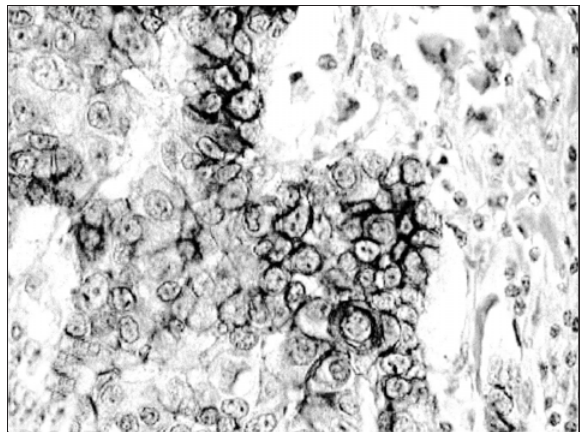
Figura 2 – Expressão da P-caderina num carcinoma invasivo da mama de alto grau histológico (grau III)